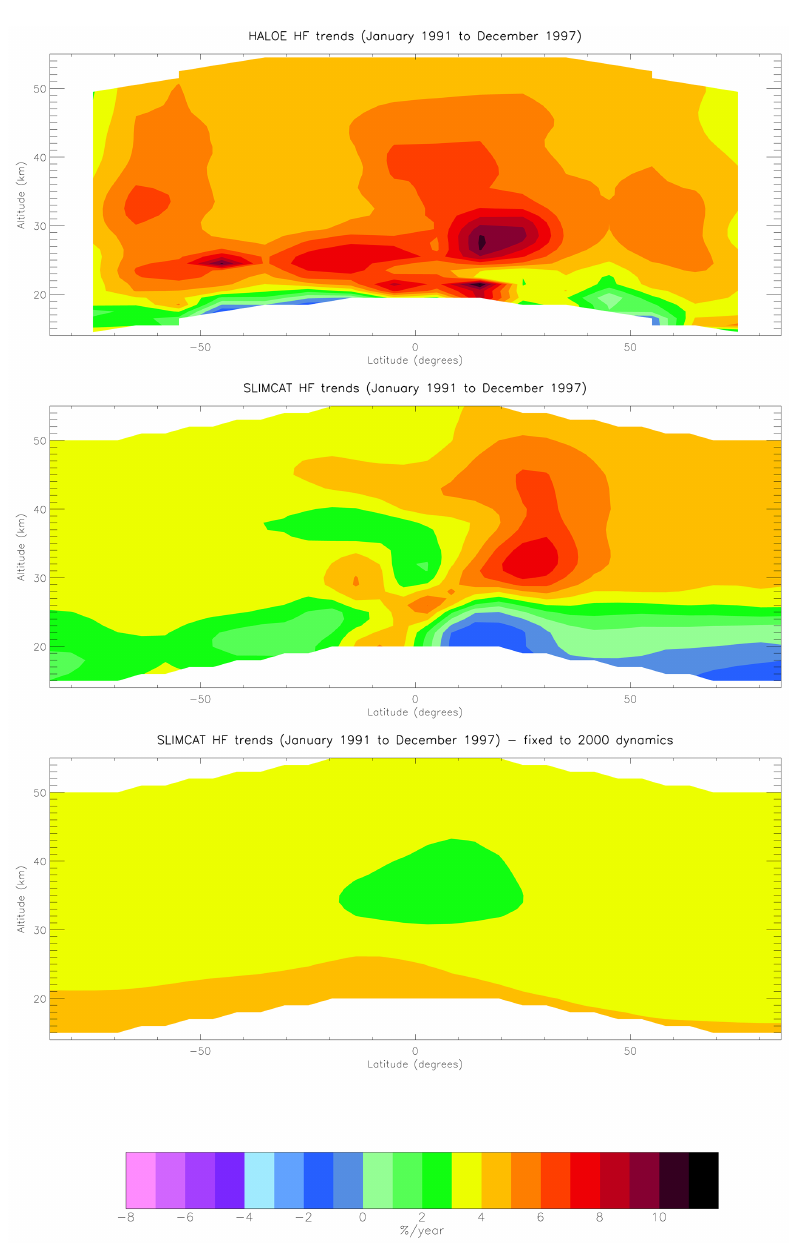
Figure 10. Trends in the growth of HF (%year − 1 ; October 1991 to December 1997) for HALOE and SLIMCAT as a function of latitude and altitude. A full discussion of these trends is provided in the